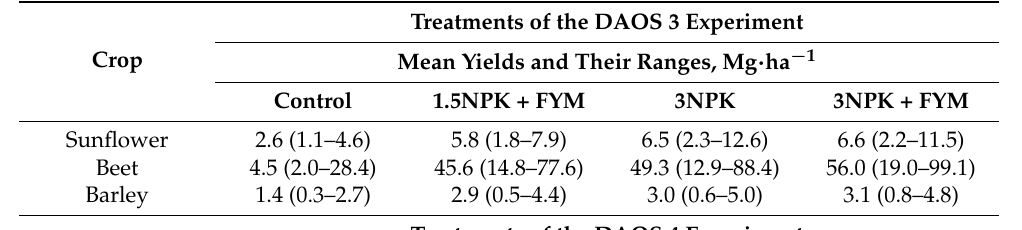
Table 1. Observed yields of the main crops used in the rotations by their treatments.